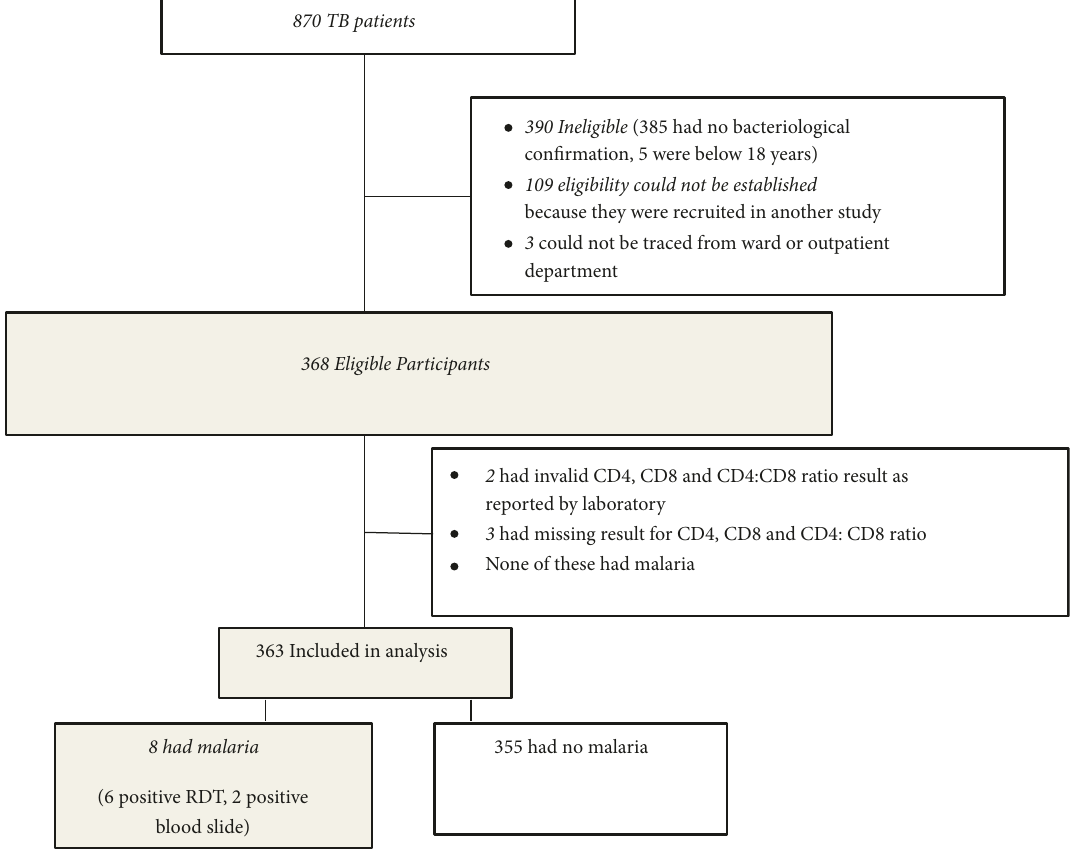
Figure 1: Figure showing study flow